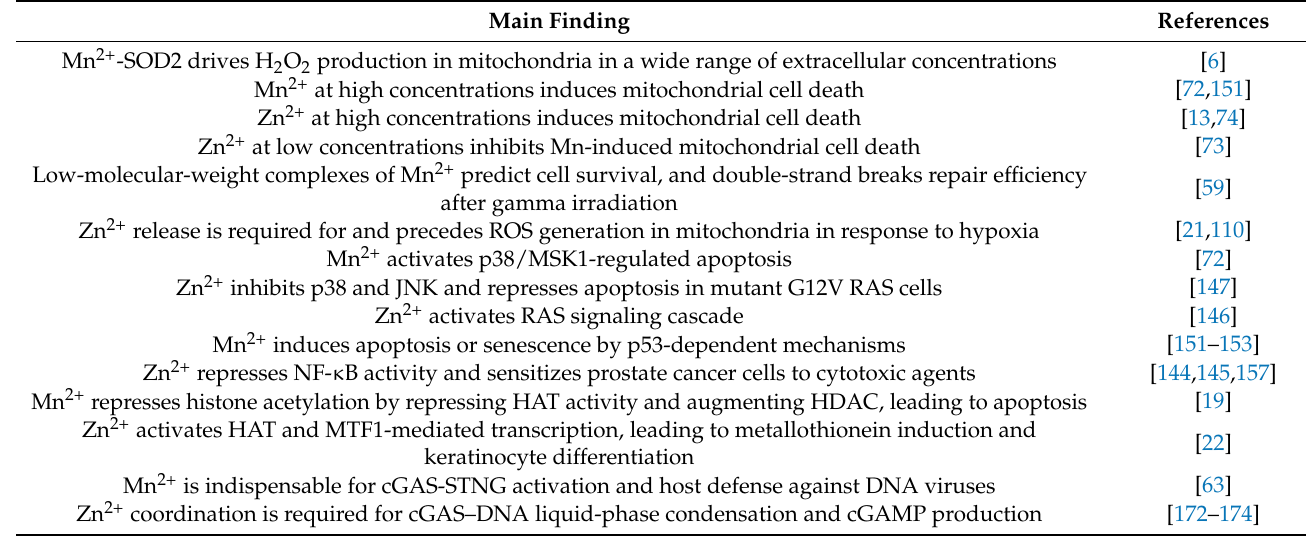
Table 3. Pivotal findings of Mn 2+ and Zn 2+ roles in cancer physiology in vitro. Main